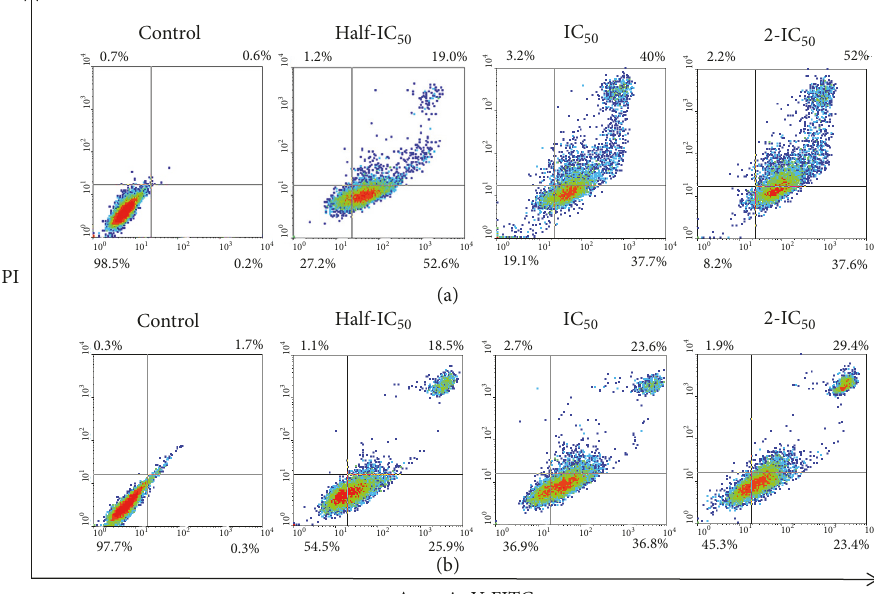
Figure 3: Apoptosis induction effect of cotyledon-acetone extract (ACE) at half IC 50 , IC 50 , and 2-fold IC 50 on HeLa (a) and SiHa (b) cells for 48 hours determined by Annexin V-FITC/PI flow cytometry. Dot plot diagrams show percentage of cell populations divided to viable (lower left quadrant; Annexin V and PI negative), early apoptotic (lower right quadrant: Annexin V positive and PI negative), late apoptotic (Upper right quadrant; Annexin V and PI positive), and dead cells (Annexin V negative and PI positive).